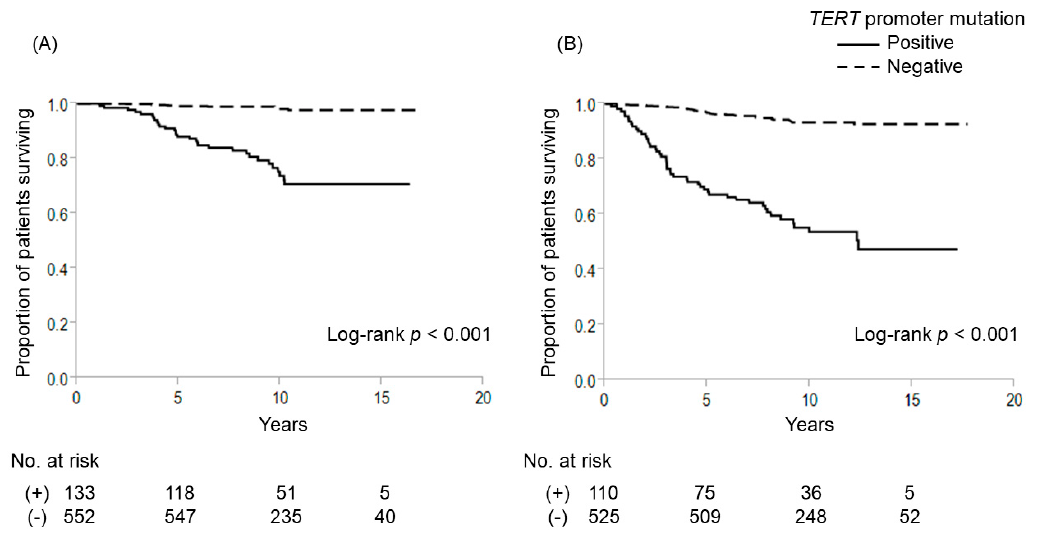
Figure 2. Cause-specific and disease-free survival curves for patients with or without TERT promoter mutations. ( A ) Cause-specific survival; ( B ) disease-free survival.